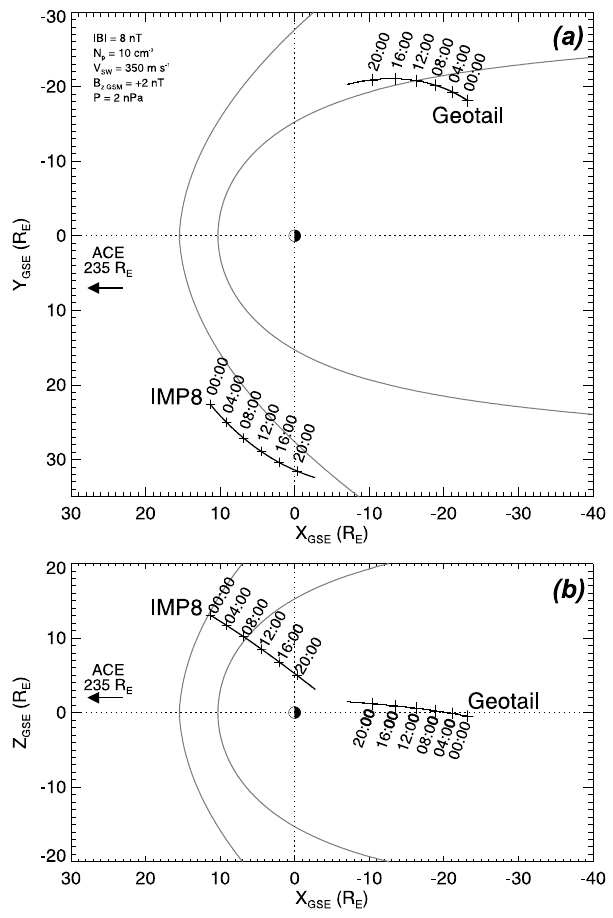
Fig. 1. The trajectories of Geotail, WIND, and IMP-8 on 18 Jan- uary 1999 in GSE coordinates. IMP-8 was located immediately upstream of the bow shock, and Geotail was performing a mag- netopause skimming orbit of the dawn flank. A modelled magne- topause (Shue et al., 1997) and bow shock (Peredo et al., 1995), cal- culated for the plasma parameters listed in panel (a) , are included for